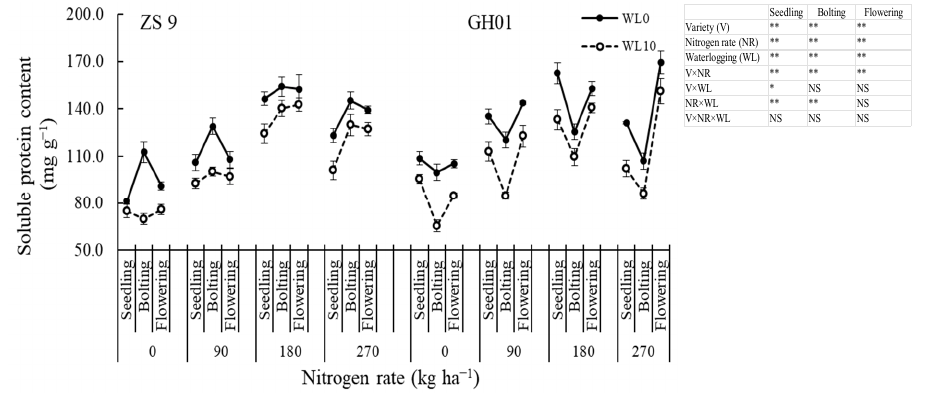
Figure 6. Effects of nitrogen rates on leaf soluble protein content of waterlogged rapeseed. WL0, plants without waterlogging; WL10, plants waterlogged for 10 days at the seedling stage. * Significant at the 0.05 probability level. ** Significant at the 0.01 probability level. NS, not significant according to ANOVA.